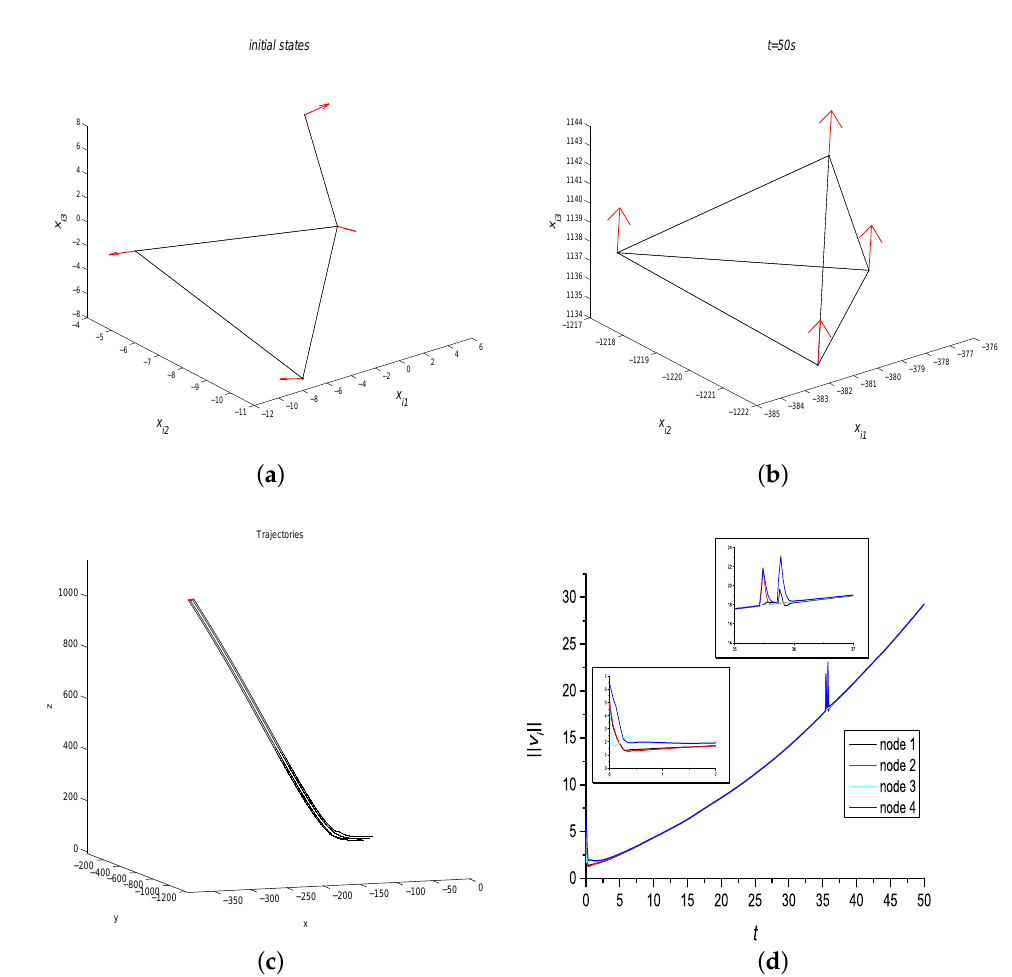
Figure 3. 3-D flocking for 4 agents applying algorithm (6). ( a ) Initial states; ( b ) states at t = 50 s; ( c ) trajectories of all agents; ( d ) velocity convergence.